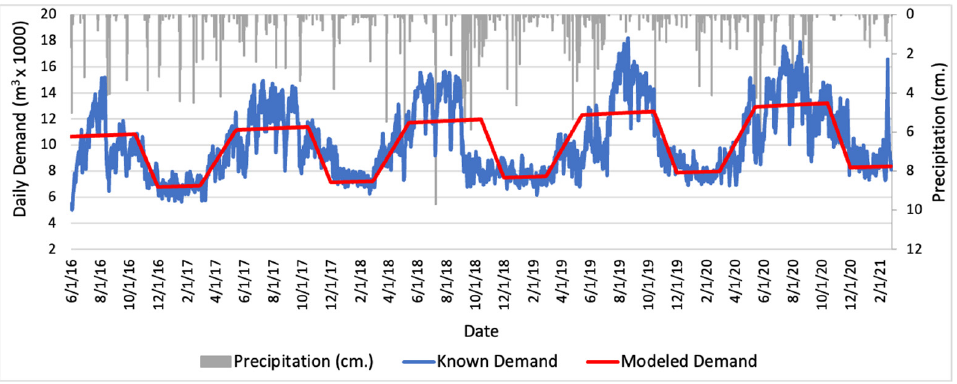
Figure 4. Calibration Period for the System Dynamics Model (1 June 2016–26 February 2021) .